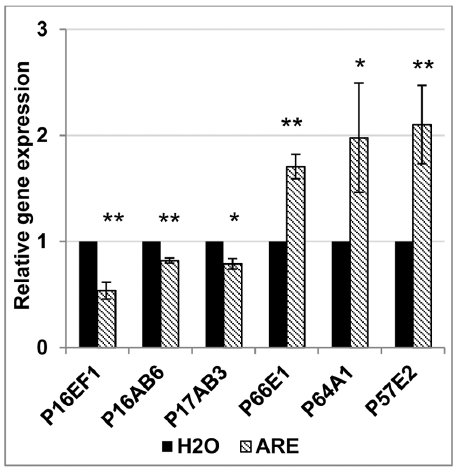
Figure 4. A.thaliana root exudates (ARE) regulate M.incognita gene expression. Gene expression analysis by qRT-PCR of 6 selected transcript-derived fragments when M. incognita juveniles are treated with ARE or water for 1 h. Error bars indicate + / 2 SEM (3 biological repeats). Statistical significance (ANOVA) of pair-wise comparisons between ARE- and water-treated nematodes is indicated as follows: